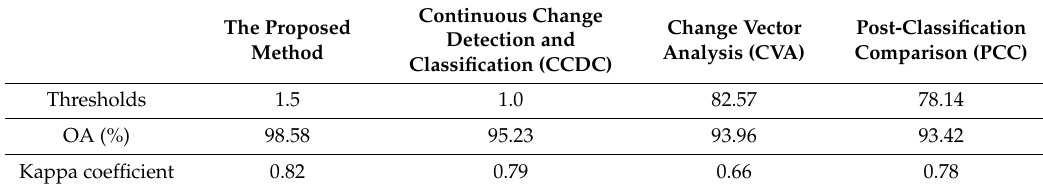
Table 3. Accuracies of the four change detection methods.